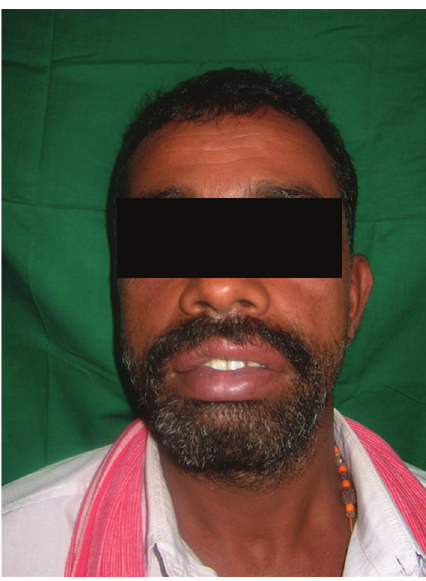
Figure 6: Postoperative view after 1